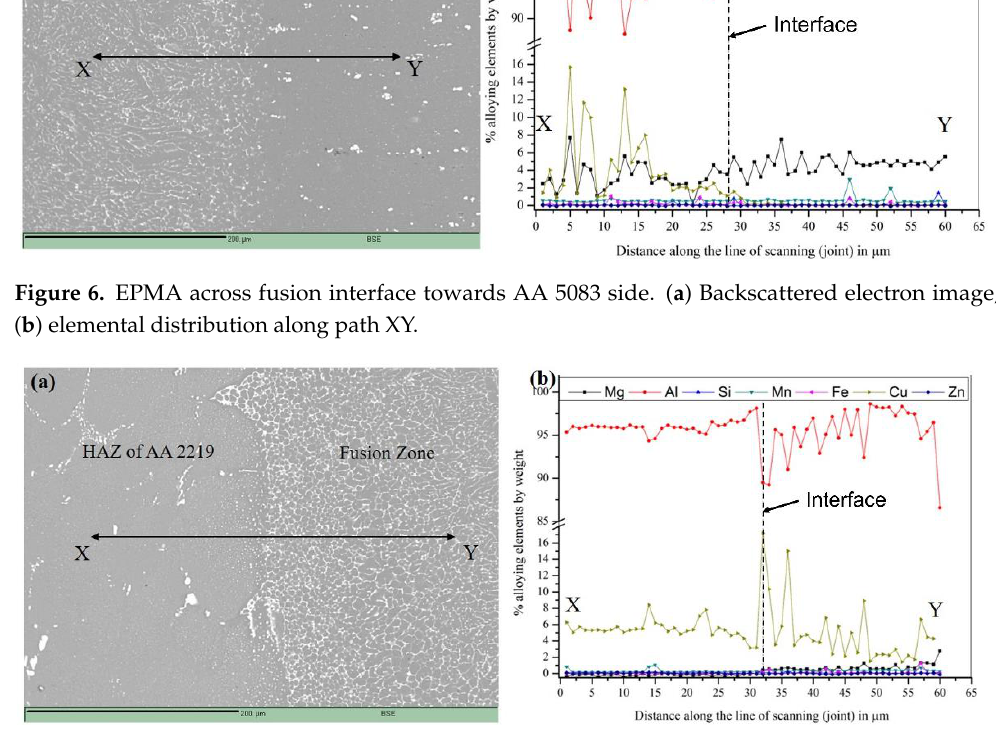
Figure 7. EPMA across fusion interface towards AA 2219 side. ( a ) Backscattered electron image; ( b ) elemental distribution along path XY.